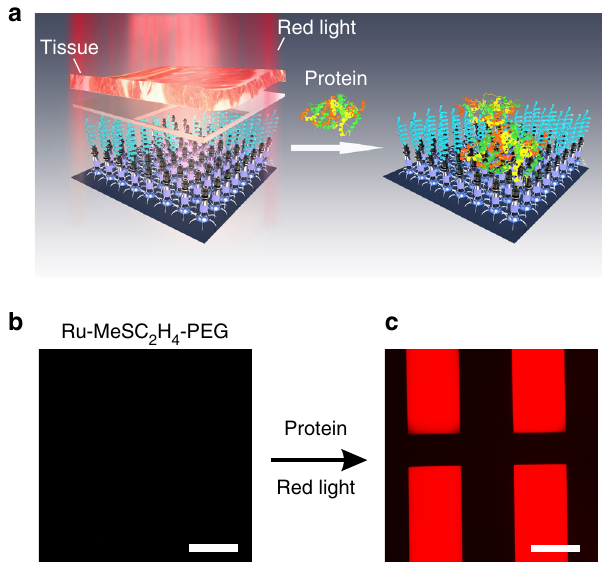
Fig. 5 Protein resistance and capture under tissue. a Schematic illustration of the fabrication of a protein pattern using red light after the light passes through a piece of tissue. Florescence microscopy images of a Ru- MeSC 2 H 4 -PEG-modi fi ed surface wetted with the fl uorescently labeled BSA solution ( b ) before and c after red-light irradiation through the tissue and photomask. Scale bars are 300 µ m